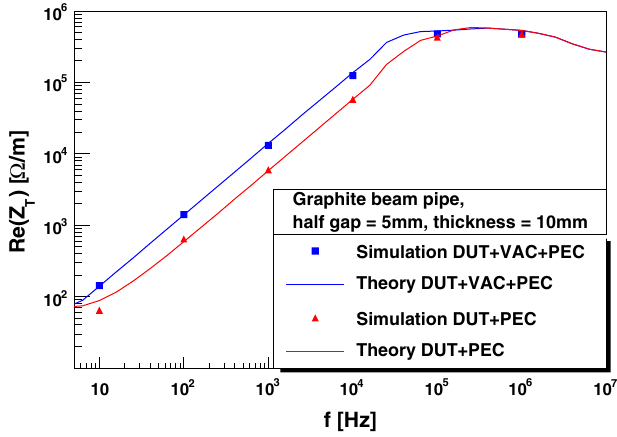
FIG. 7. (Color) Real part of the transverse impedance as calcu- lated by numerical simulations [21] and analytical models [1] (cf. Sec. II) for cylindrical graphite beam pipes. PEC stands for perfect electrical conductor and VAC for vacuum. The effect of adding a 30 mm vacuum layer between the DUT and the PEC boundary is evident at low